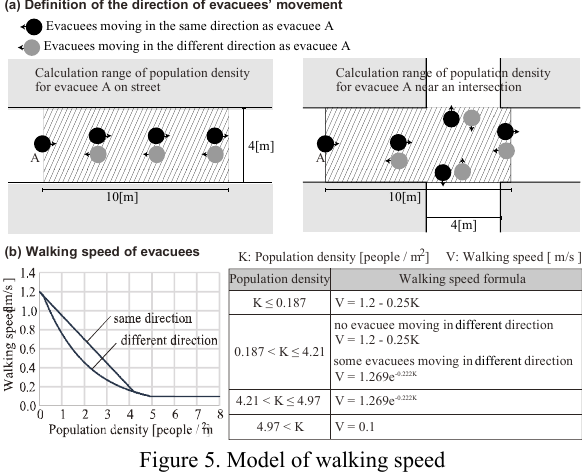
Figure 5. Model of walking speed